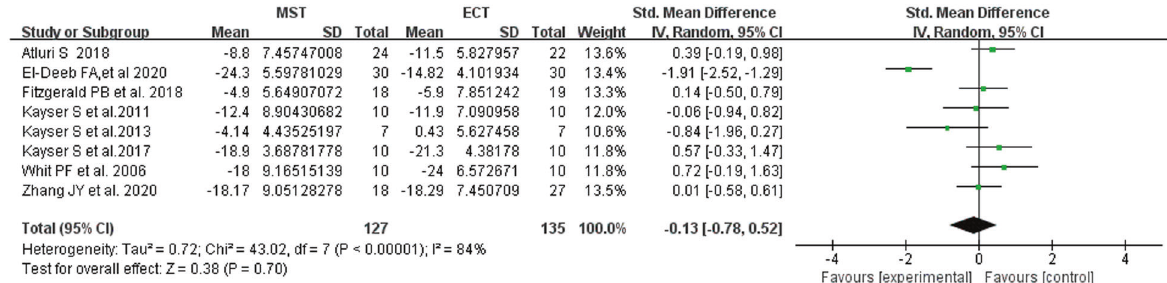
Fig. 2 Forest plot of the ef fi cacy of MST and ECT in the treatment of depression.